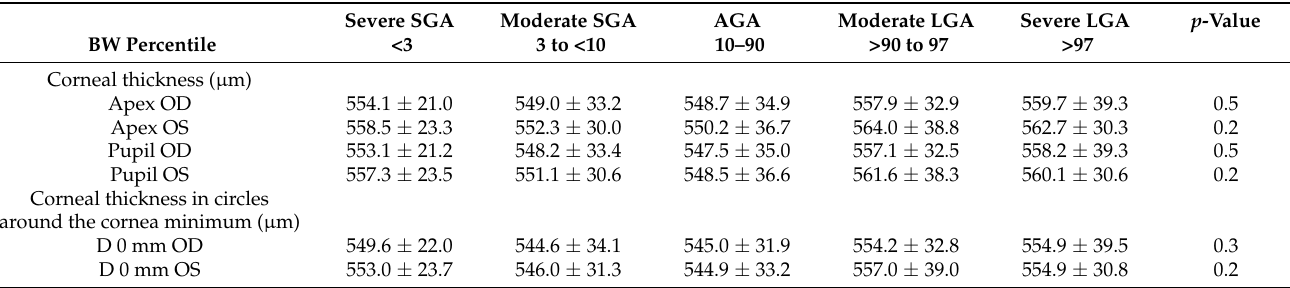
Table 3. Corneal thickness in different locations for each study